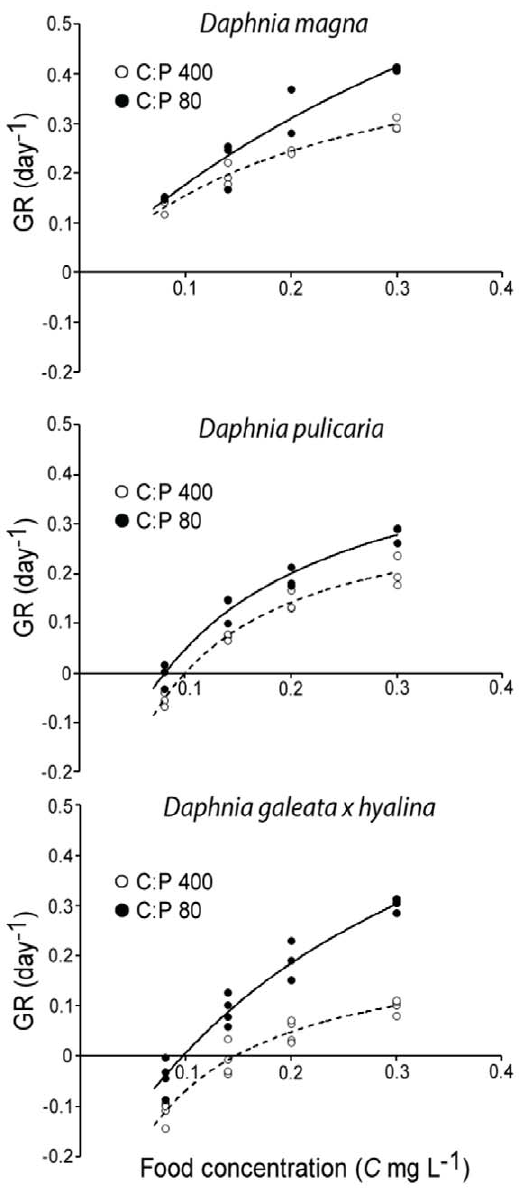
Figure 3. Specific growth rates (GR) of 4-day-old D.magna , D. pulicaria and D.galeataxhyalina cultured on P-poor (C:P 400; open symbols) and P-rich (C:P 80, closed symbols) algal food at four food concentrations (0.08, 0.14, 0.2 and 0.3 mg C L 2 1 ). Lines were fitted using the Monod model.